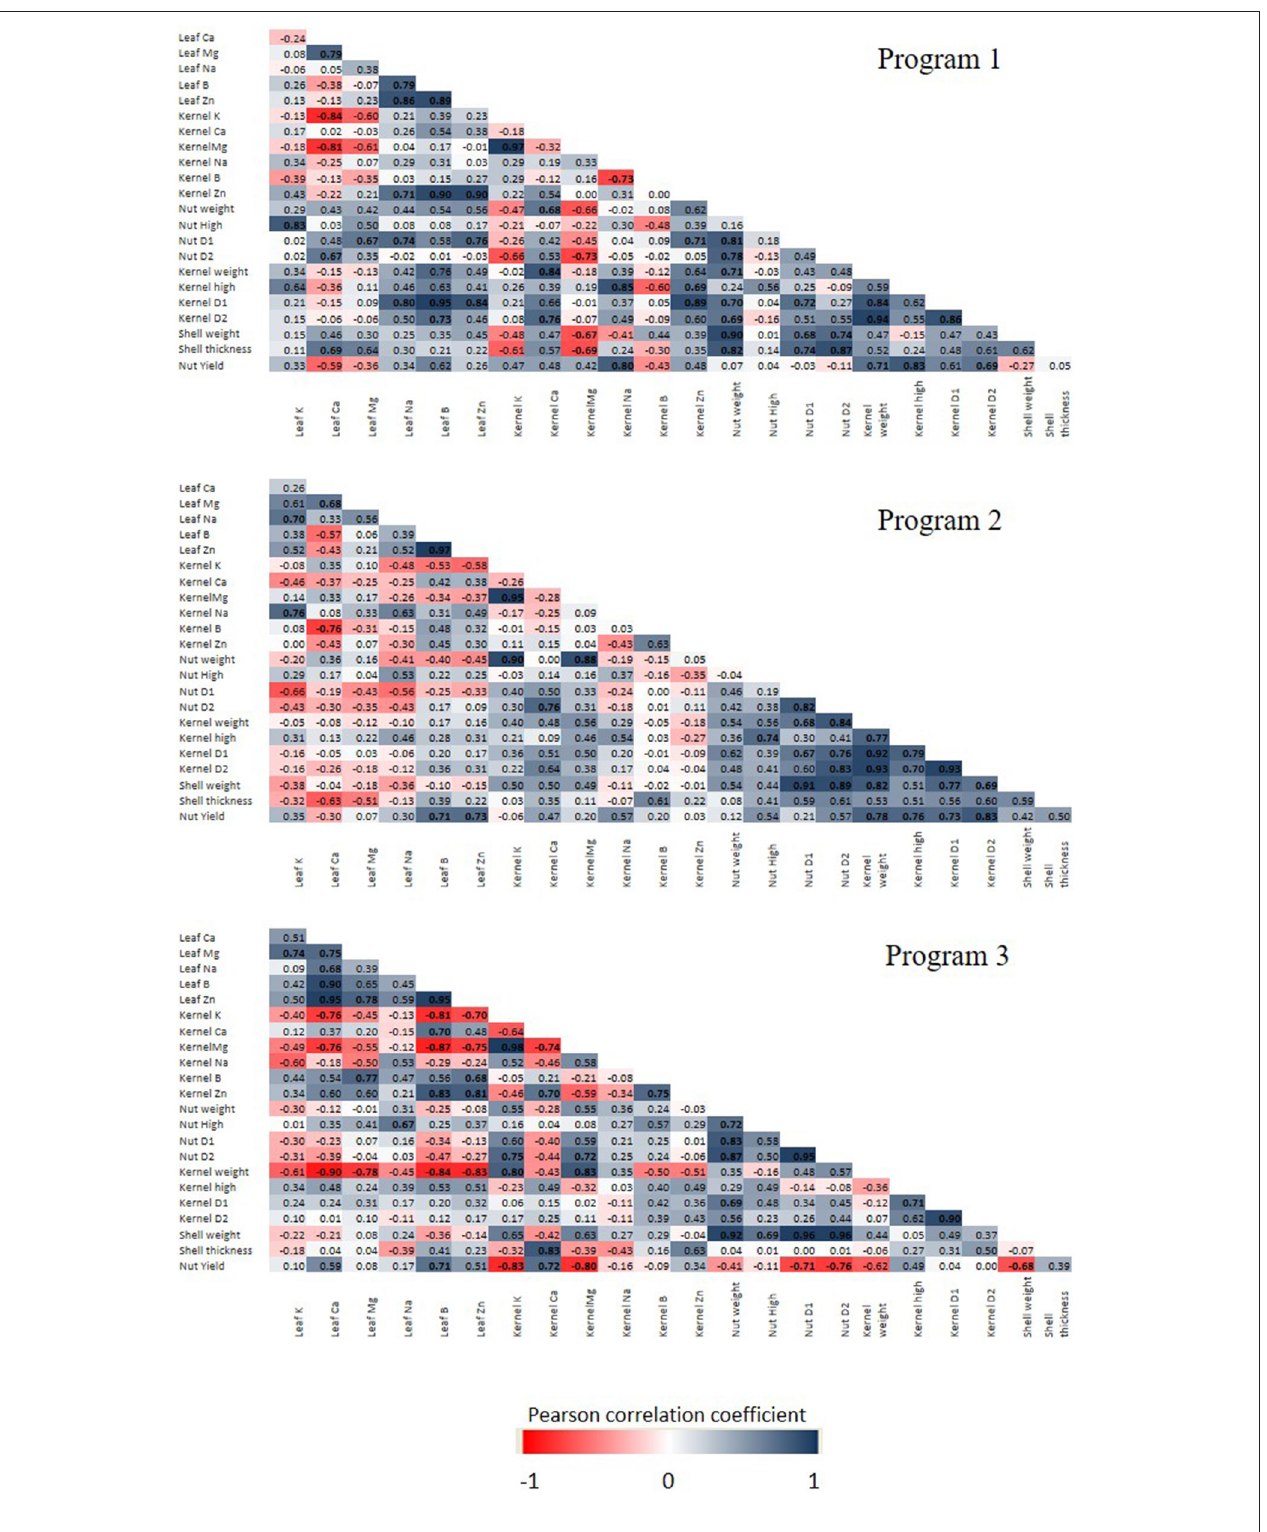
FIGURE 6 | Pearson’s correlation coefficient matrix between nutrient concentration and yield performance of hazelnut cultivar TDG. Correlation was calculated at three spraying programs (1, 2, and 3), and three B (0, 800, and 1,600mg L − 1 ) and Zn (0, 400, and 800mg L − 1 ) concentrations. Pearson’s coefficient that is significant at P < 0.05 is indicated by boldface. Positive and negative correlations are distinguished by blue and red colors, respectively.